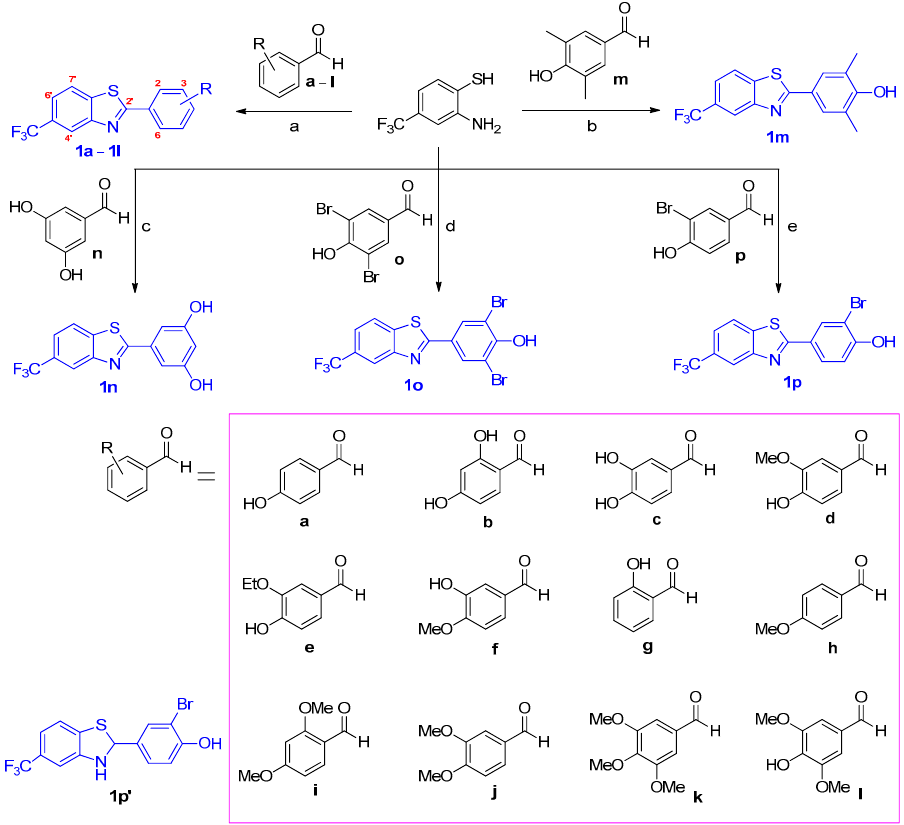
Figure 1. The structures of compound 1a and kojic acid, and the mushroom tyrosinase inhibitory activities of these compounds.